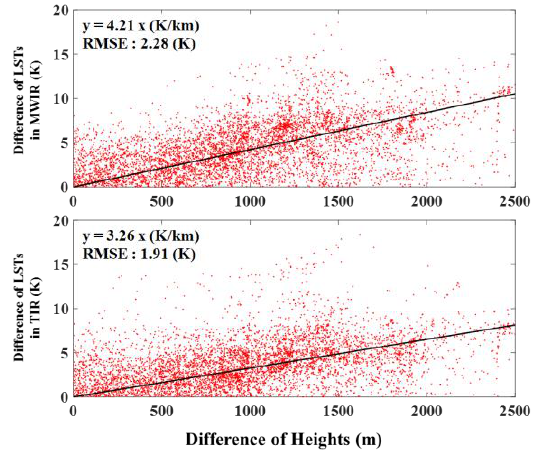
Figure 1. Estimated brightness temperature lapse rate at 18:00 on May 6, 2017 (UTC)